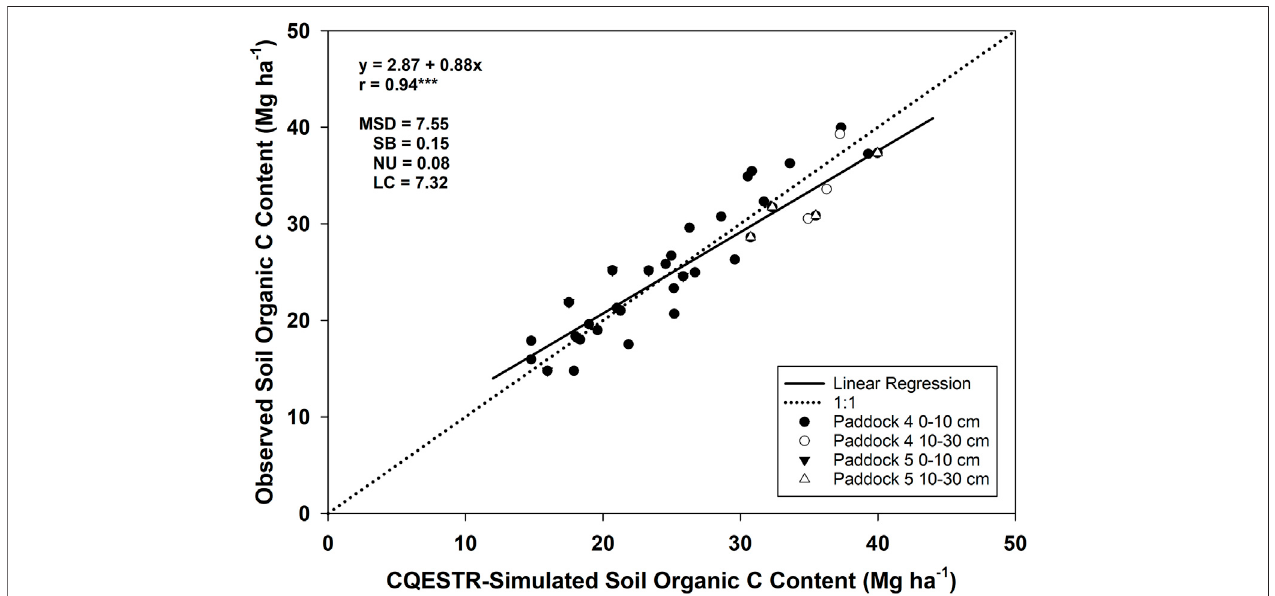
FIGURE3| Observed andsimulatedsoil organiccarbon (SOC) stocks at 0 – 10and 10 – 30 cmdepths for Paddock 4and Paddock 5inaTypic Acrustox soilunder integrated crop-livestock system at Santo Antônio de Goiás, GO, Brazil. Dotted line refers to 1:1 correspondence of measured and simulated values. Observed and simulateddataweresigni fi cantlycorrelated( p < 0.0001)withaPearsoncorrelation (r)of0.94.MSD, meansquareddeviation;SB,squaredbias;NU,nonunityslope;LC, lack of